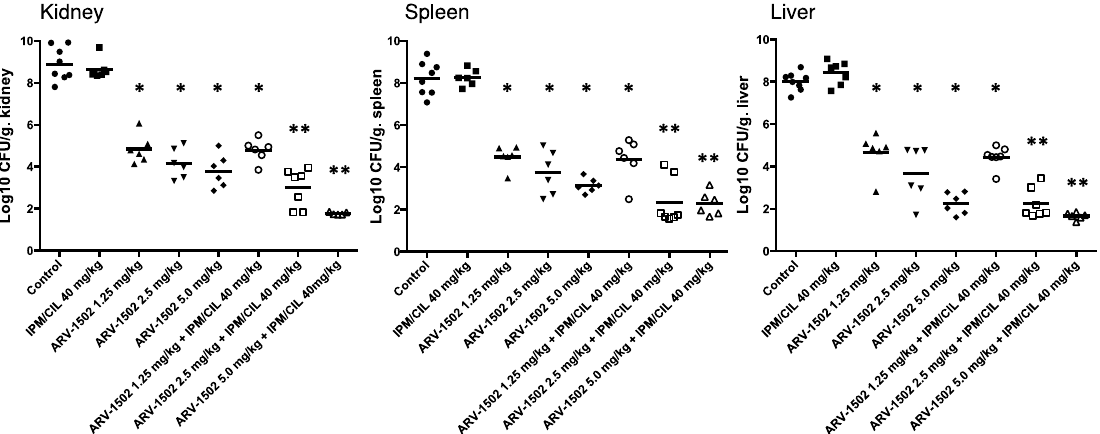
Figure 3. A. baumannii burden in the target tissues (kidney, spleen and liver) were quantified as CFU per gram of target tissues in the murine bacteremia model following different regimens. * p < 0.001 vs. control and IPM/CIL alone groups, ** p < 0.05 vs. respective ARV-1502 monotherapy group, using Student’s t -test. At least six mice per group were analyzed.